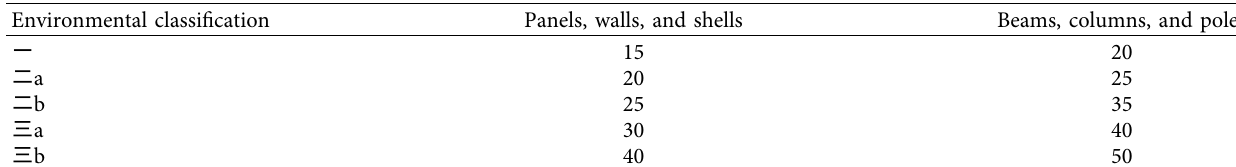
Table 4: Minimum thickness of concrete cover (mm).